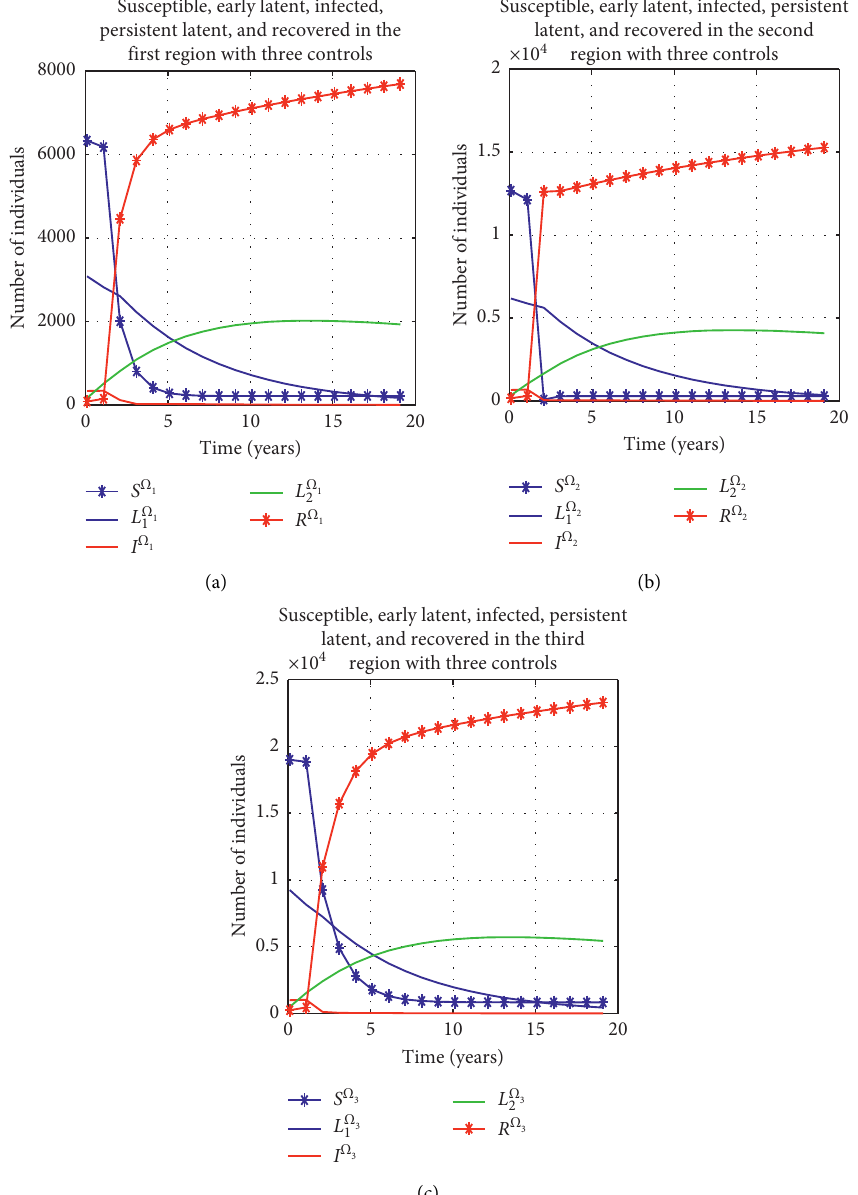
Figure 8: The state variables in three regions with controls vaccination, travel blocking, and